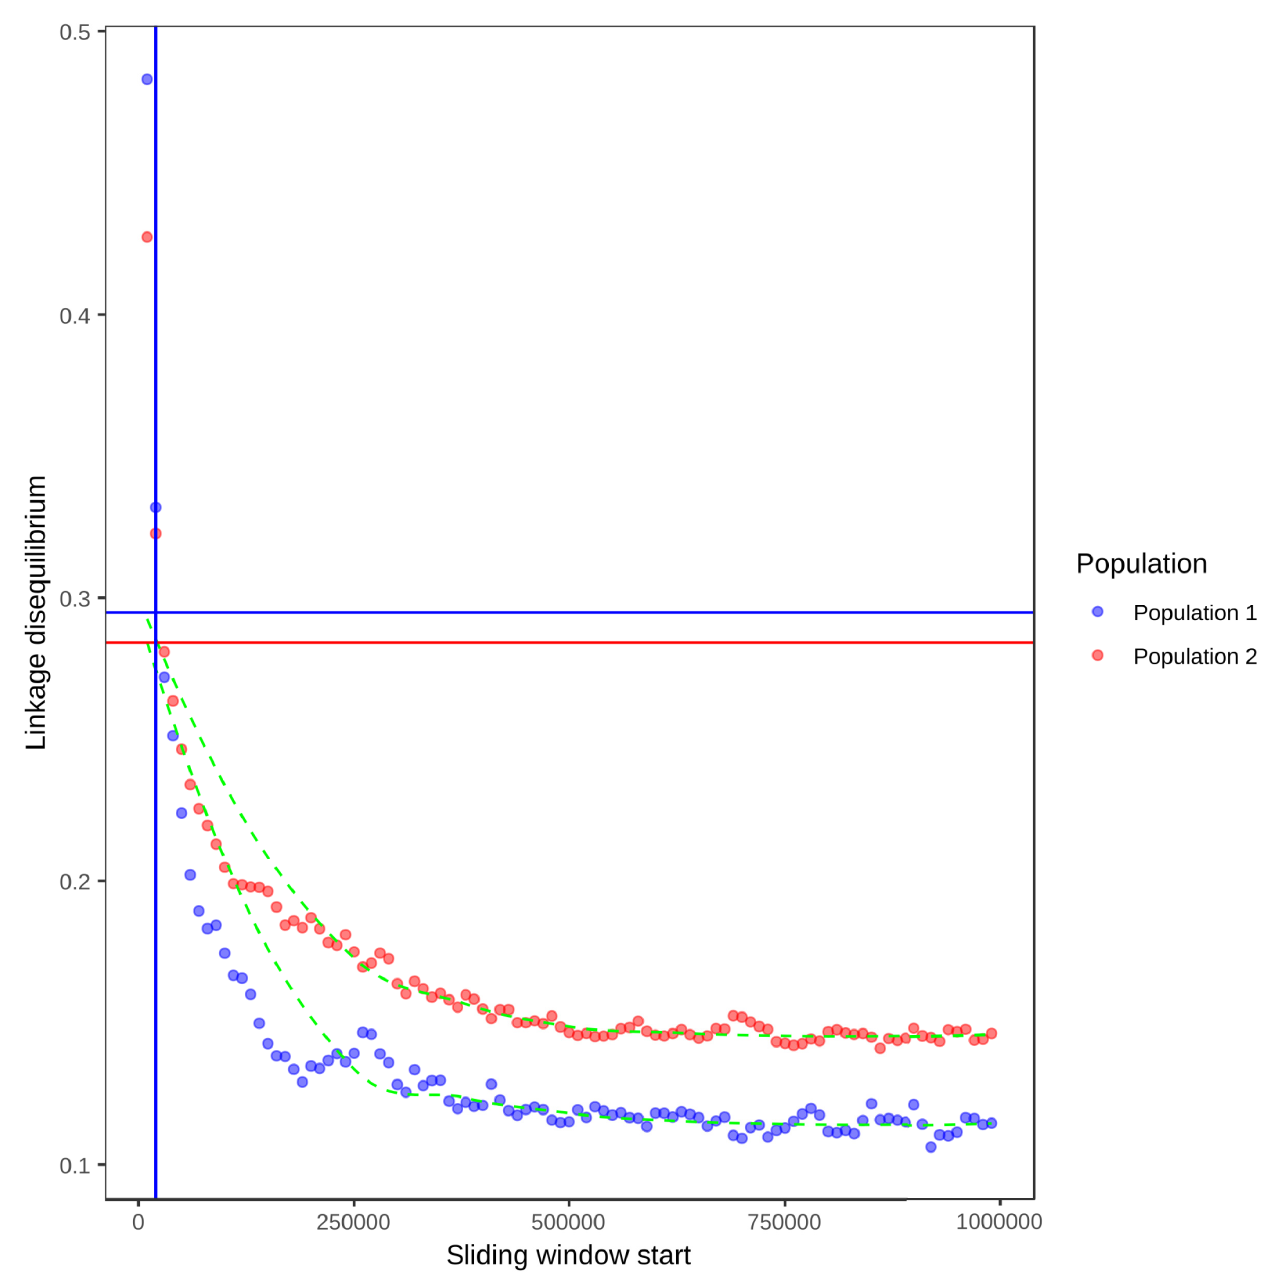
Fig 2. Linkage disequilibrium decay in the two defined Sclerotinia sclerotiorum populations. Mean linkage disequilibrium (x axis) is plotted for 10 Kb sliding windows up to 1000 Kb from each SNP. The green dashed lines are LOESS curves fit to the mean linkage disequilibrium values. Points are in blue for population 1 (North American and European isolates) and red for population 2 (Australian isolates and a single Moroccan isolate). The vertical lines indicate the position at which linkage disequilibrium decayed to half its maximum value in each population, with population 1 in blue and population 2 in red (red and blue fall together at the same window start, so the red line is not visible). The horizontal lines represent half the maximum linkage disequilibrium for each population, with population 1 in blue and population 2 in red.